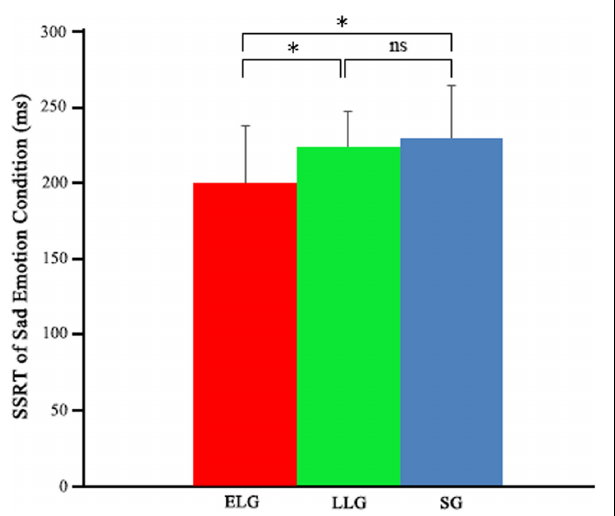
FIGURE 3 | Emotional Stop Signal Task performance (sad condition) between ELG, LLG, and SG. eSST, emotional Stop Signal Task; SSRT, stop signal reaction time; ELG, early stage lovers; LLG, longer period lovers; SG, single group. ∗ p < 0.05; ns, not